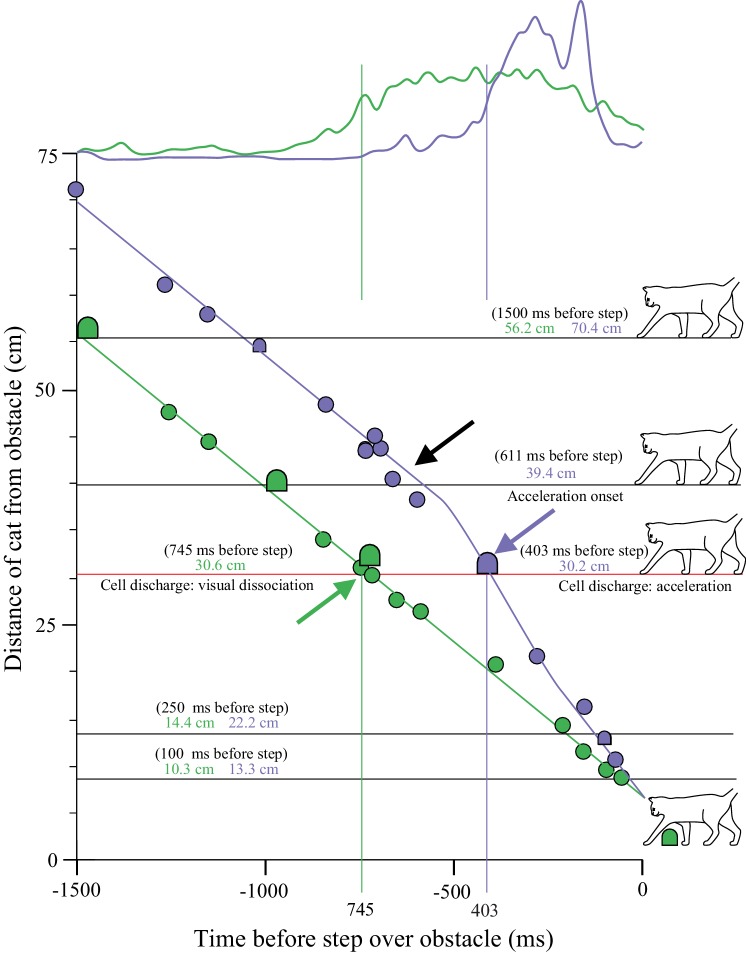
Relationship between time and distance for the visual dissociation and the 1L acceleration task.The two traces at the top repeat the display of cell activity from Figure 7C during the visual dissociation task (green) and during acceleration (purple). The graph shows the relationship between distance and time with respect to the step over the obstacle (time = 0). During the visual dissociation task, there is a linear relationship between the two variables (green line and symbols). In the acceleration task (purple line and symbols), there is a linear relationship until the acceleration begins and then the distance between the obstacle and the cat decreases more rapidly. The text indicates the distance of the obstacle from the cat for exemplar times for the visual dissociation (green values) and the acceleration (purple values). We concentrate on three times indicated by arrows. (1) The green arrow indicates the distance of the obstacle (30.6 cm) at the onset of the cell discharge during the visual dissociation task (745 ms). (2) The black arrow indicates the time at which we applied the acceleration. At that time, the obstacle was 39.4 cm from the cat but, because of the acceleration, took only 611 ms to close the gap to the cat. (3) In the acceleration condition, cell onset occurred 403 ms before the step over the obstacle. At this time, the obstacle was 30.2 cm from the cat, almost the same distance as when the cell fired in the unperturbed condition. Other values provide the distance of the obstacle from the cat in the two conditions for selected times before the step over the obstacle.